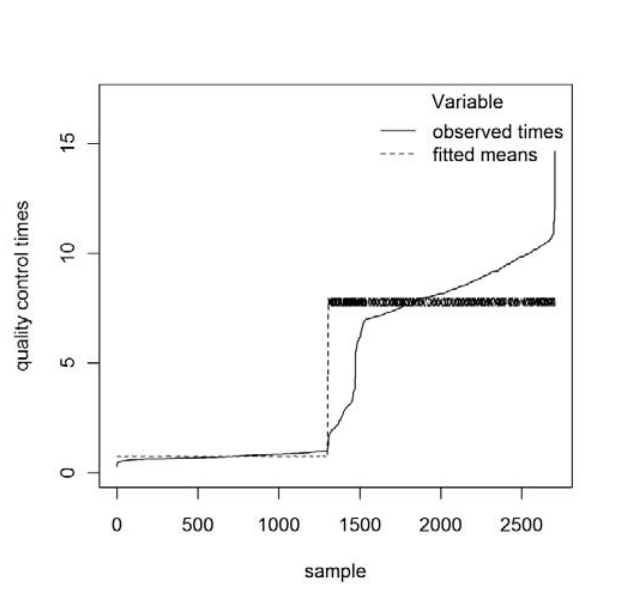
Fig. 5. Quality control times and fitted means versus samples (all data set)